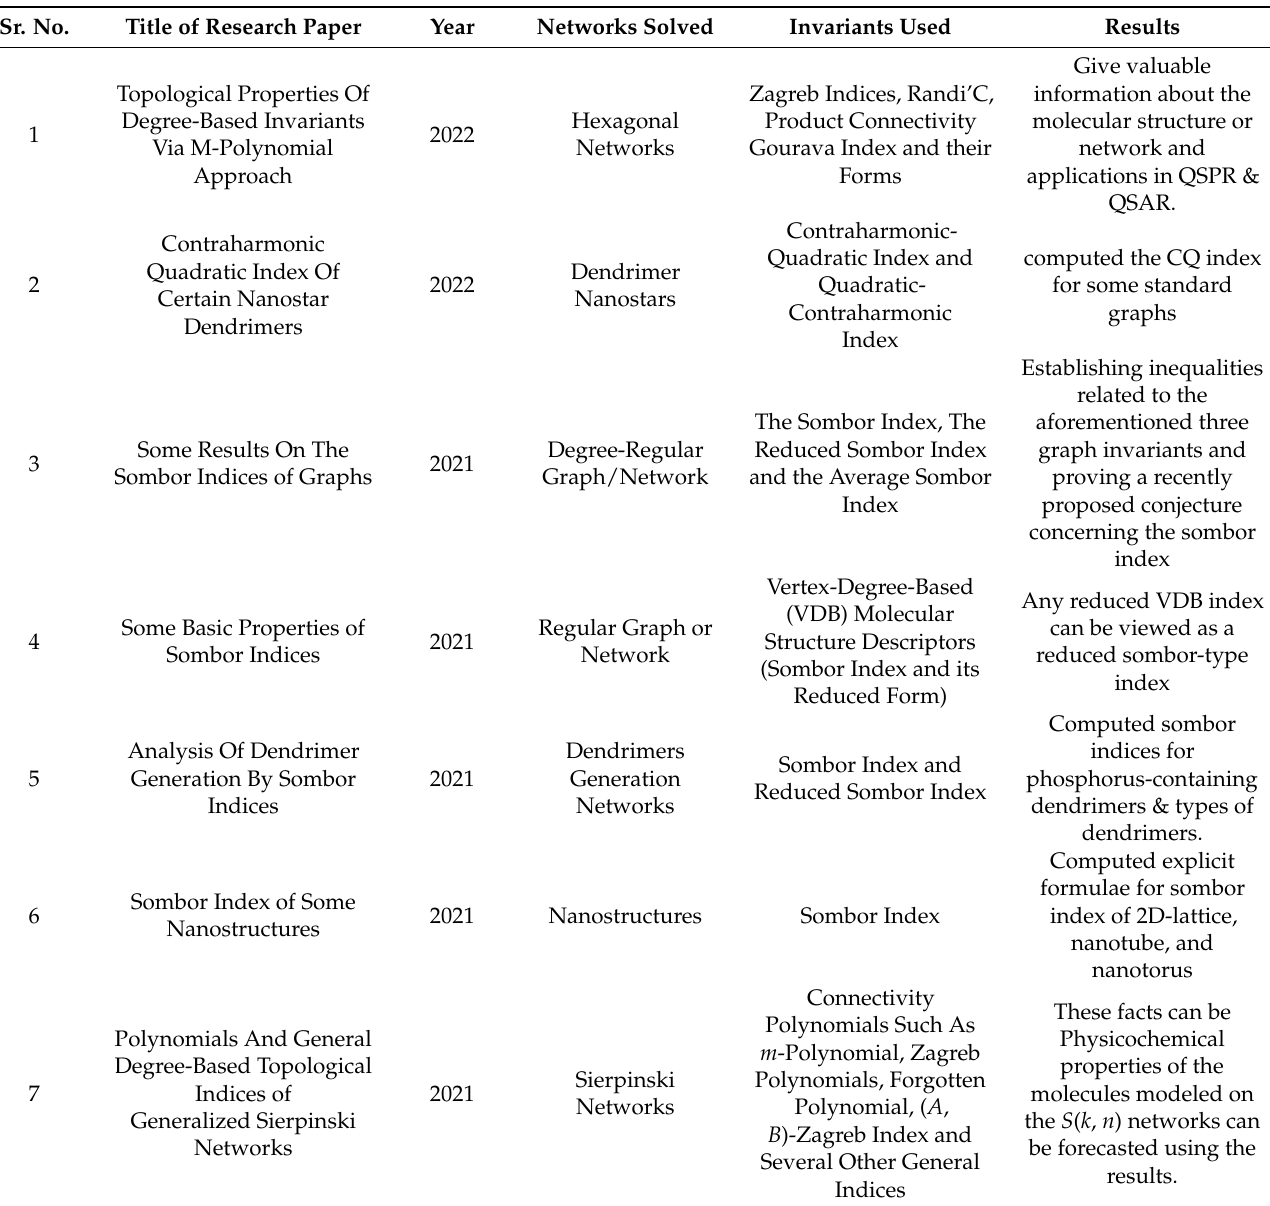
Table 1. Analytical Comparison of Topological Invariants and their